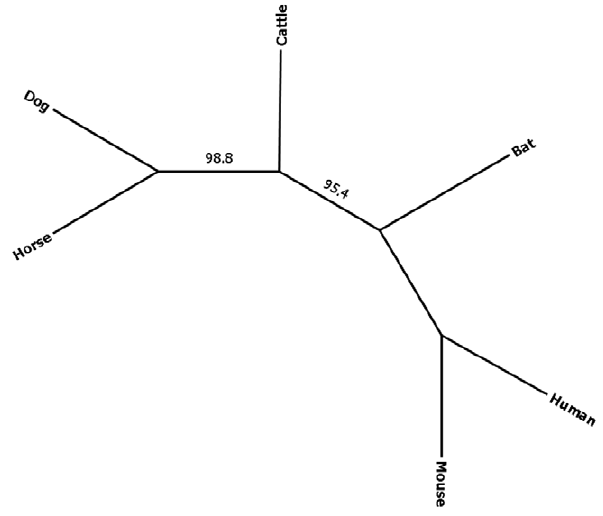
Figure 8. Unrooted species tree from the orthologous dataset across six Boreoeutheria mammals. The species tree was generated from 2378 gene loci. There was 95% bootstrap support for placing bats (Chiroptera) sister to Perissodactyla, Cetartiodactyla, and Carnivora.